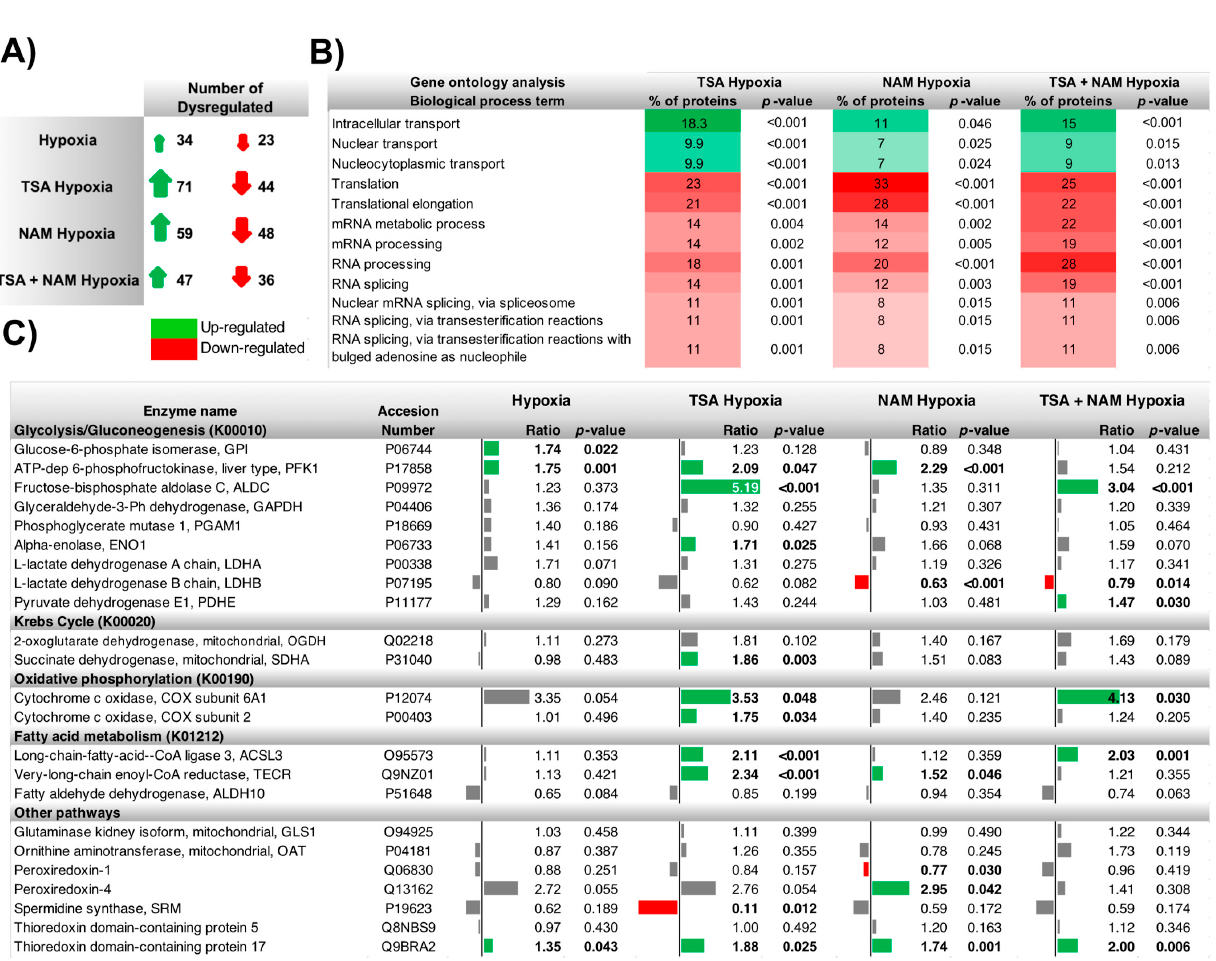
Figure 5. Effect of KDAC inhibition and hypoxia on the global proteome and metabolic enzymes compared to control A549 cells under normoxia. Quantitative proteomic analysis of differentially expressed proteins in A549 cells treated with 1 μ M of TSA, 20 mM of NAM, and both 1 μ M TSA and 20 mM NAM for 24 h under hypoxic conditions. ( A ) The number of up-regulated and down-regulated proteins (iTRAQ ratio > 1 and <1, respectively) showing significant ( p -value ≤ 0.05) differences between TSA, NAM, and TSA/NAM treatments under hypoxia with respect to control cells under normoxia. ( B ) GO enrichment analysis of the Biological process term for each condition shown as the percentage of proteins related to each process. All biological processes are shown as significantly ( p -value ≤ 0.05) up-regulated or down-regulated. ( C ) Quantitative measurement of the main metabolic enzymes identified using the iTRAQ approach for the different conditions compared to untreated control cells under normoxia. Significantly up-regulated enzymes (iTRAQ ratio > 1 and p -value ≤ 0.05) are represented in green and significantly down-regulated enzymes (iTRAQ ratio < 1 and p -value ≤ 0.05) are represented in red. Non-significantly up-regulated and down-regulated enzymes are represented in